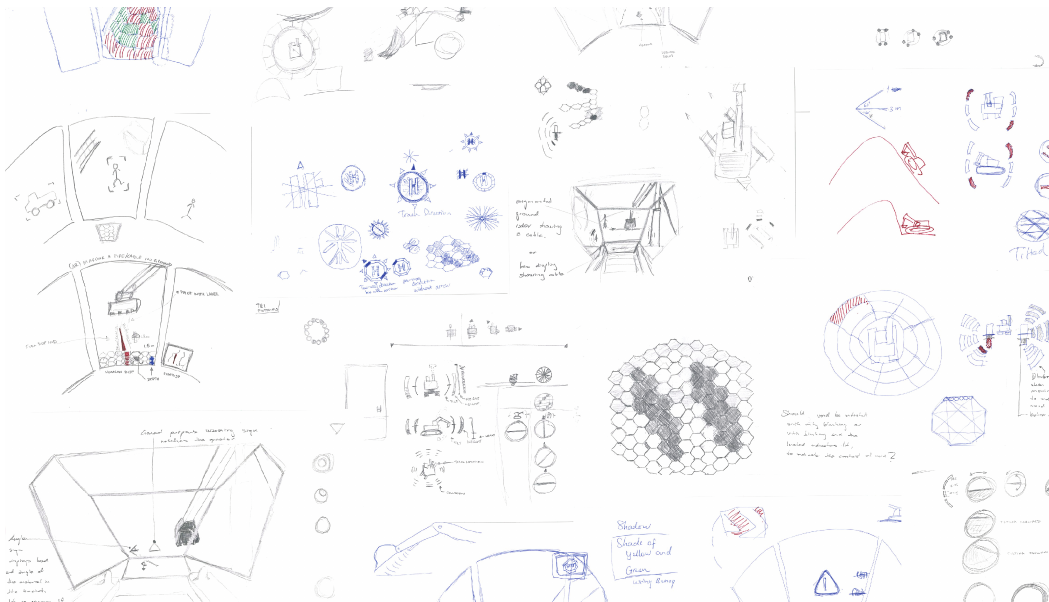
Figure 4. The image that shows some sketches generated from our design workshop. Some sketches on the left side were made as if the entire windshield could work as a display, which are currently not possible due to the limitation of transparent displays. The other sketches show some visualization concepts that were closely made based on both capability and limitation of transparent